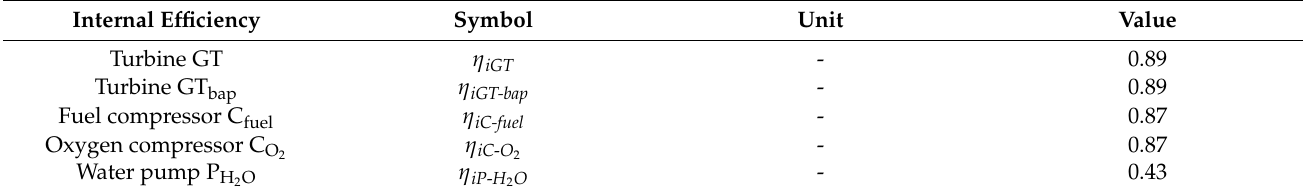
Table 4. Assumed internal efficiency (adiabatic for Hysys and isentropic for Aspen Plus and Ebsilon).